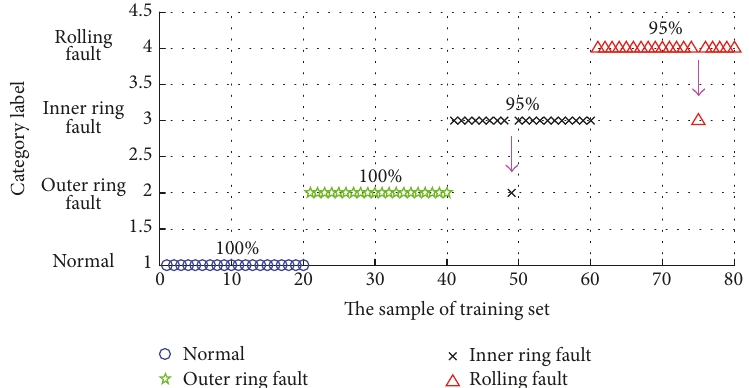
Figure 13: Classification of testing data based on BA-ELM.